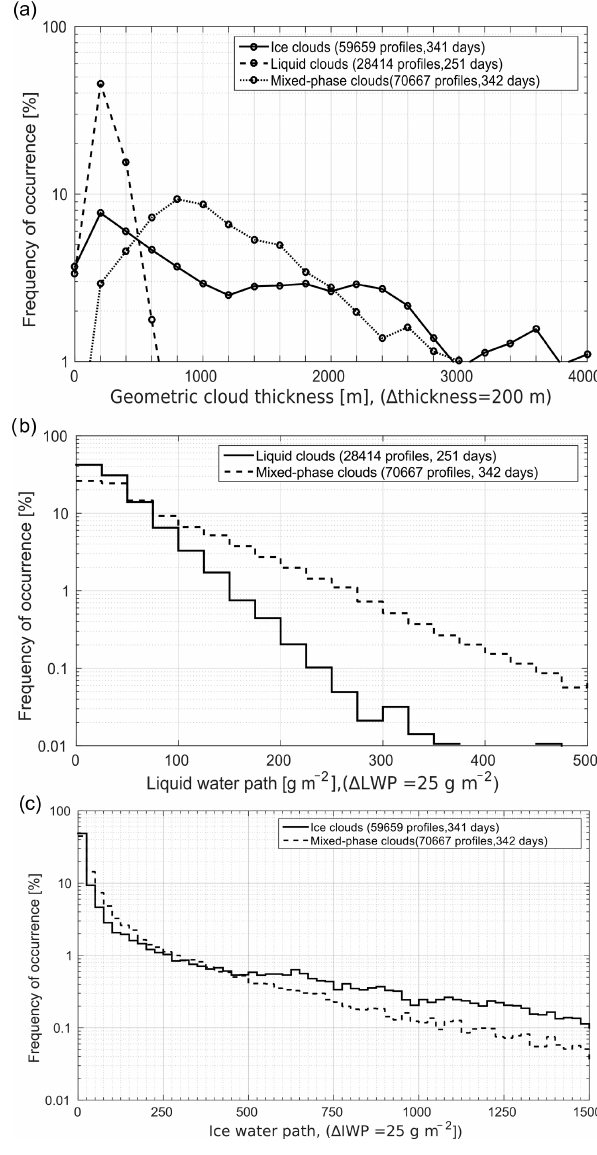
Figure 11. Frequency of occurrence of cloud thickness for single- layer clouds (a) , LWP for single-layer liquid and mixed-phase clouds (b) , and IWP for single-layer ice and mixed-phase clouds (c) for the period from June 2016 to July 2017. The y axis is shown in logarithmic scale. In the x axes (cid:49) shows the bin width. The fre- quency of occurrence is normalized by the total number of corre- sponding cloud